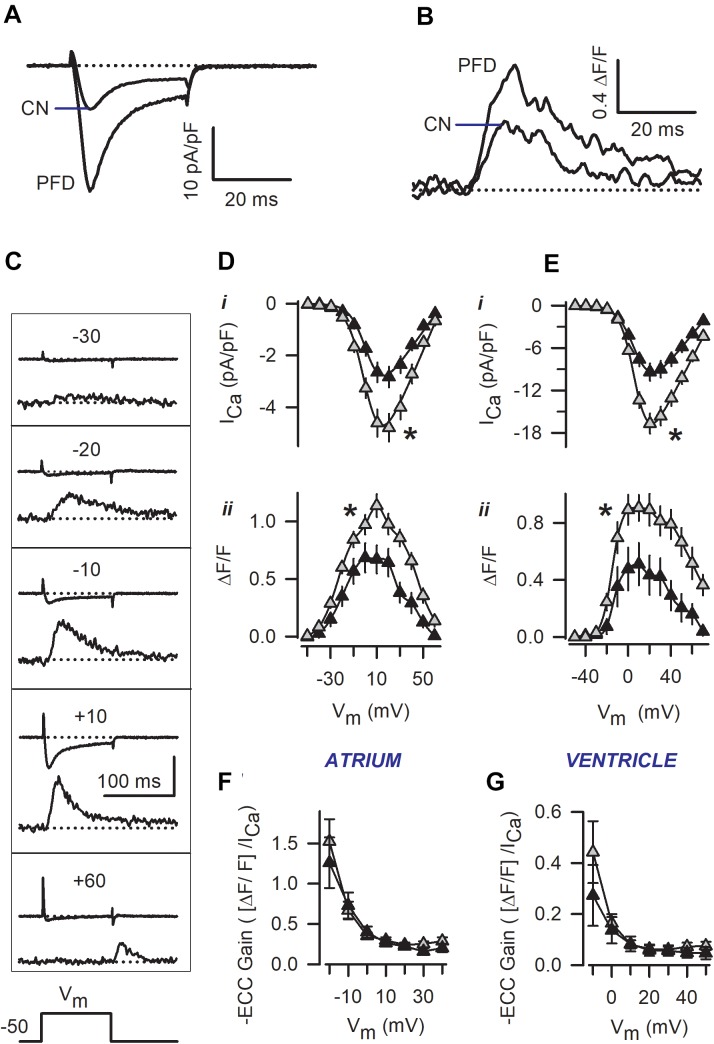
Patch-clamp experiments reveal a pirfenidone (PFD)-induced increase in the magnitude of both ICa and Ca2+ transients. Representative traces of ICa and Ca2+ transients that were recorded simultaneously in either ventricular (A,B) or atrial myocytes (C). In (A,B), recordings obtained from control (CN) and PFD-treated (PFD) myocytes were superimposed, and the membrane was depolarized to +10 mV. In contrast, (C) illustrates traces obtained at different membrane potentials (Vm, in a control cell; the vertical calibration bar indicates 100 pA and 1.0 ΔF/F). (D,E) Average peak values of ICa (i) and Ca2+ transients (ii) that were obtained as in (C), for both atrial (D), and ventricular (E) myocytes. Results are from a total of 28 atrial (11 CN, 17 PFD) and 32 ventricular (17 CN, 15 PFD) myocytes. (F,G) Voltage-dependence of ECC gain, estimated from data shown in (D,E). Closed and gray symbols denote control and PFD-treated cells, respectively. ∗p < 0.05, ANOVA.